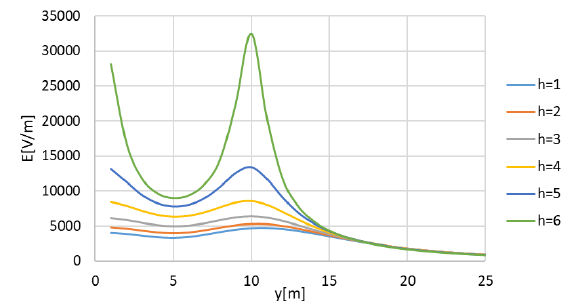
Fig. 4. Profile of the electric field intensity near the 220 kV before optimization.